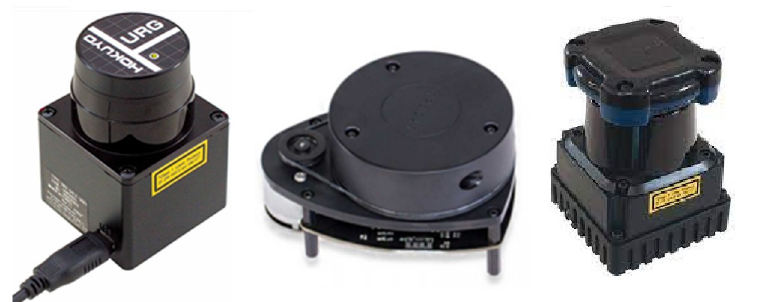
Fig 1. 2D Laser scanners (left) URG-04LX (middle) RPLidar A1 (right)